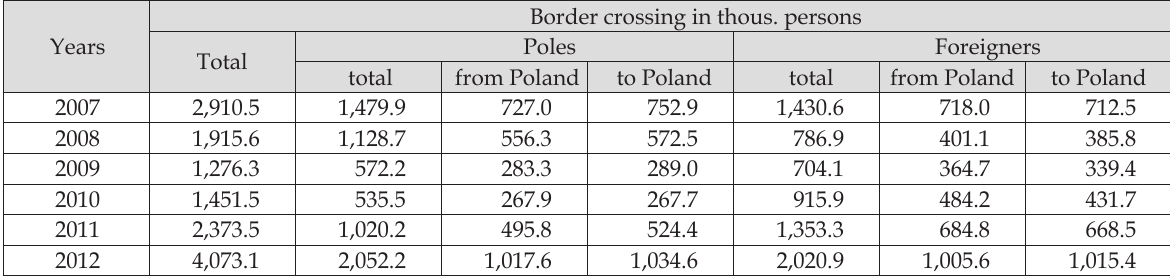
Table 1. Individual traffic on the Polish border with the Kaliningrad Oblast of the Russian Federation in the years 2007–2012 Border crossing in thous. persons Years Total